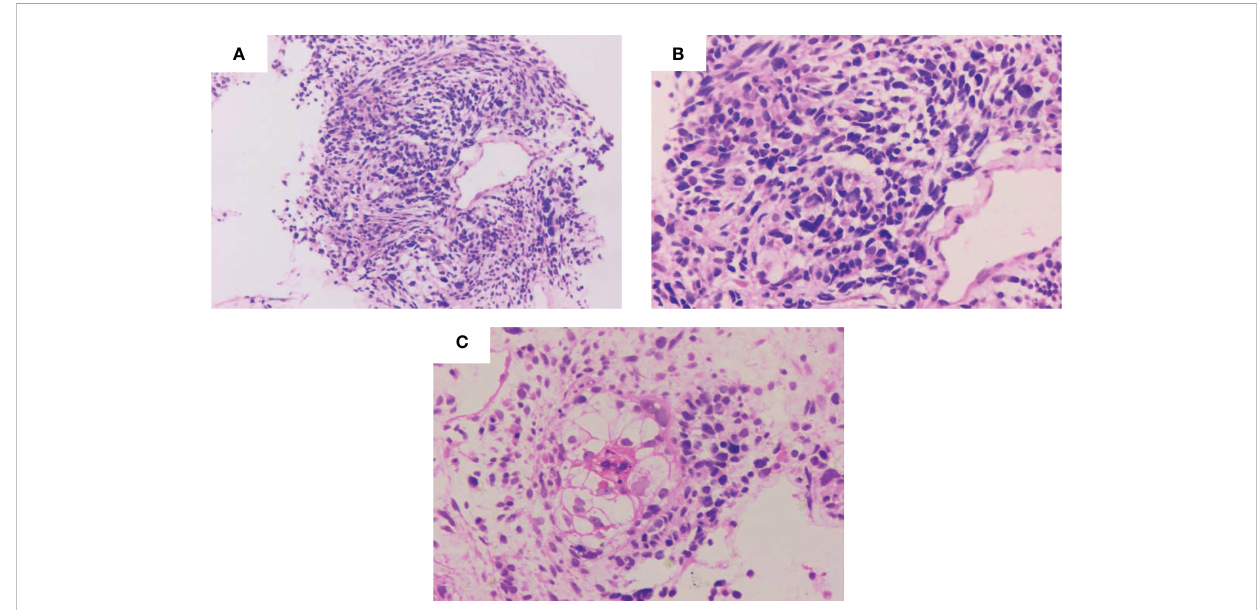
FIGURE 1 Pathological images of the pulmonary blastoma patient. (A-C) Representative images showing spindle-shaped or oval tumor cells with diffuse in fi ltrative growth, necrosis of limited cartilage components, and loose interstitium. (A) Microscopic magni fi cation ×100. (B, C) Microscopic magni fi cation